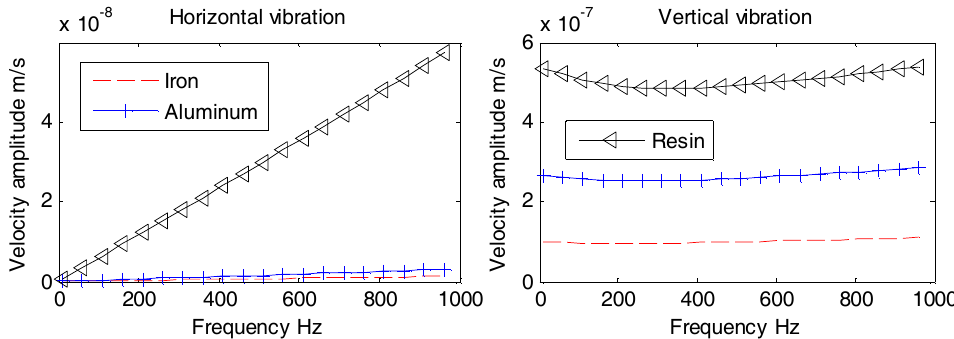
Figure 14. Vibration velocity amplitudes of the OBSs with different densities under incident angle of 60°.